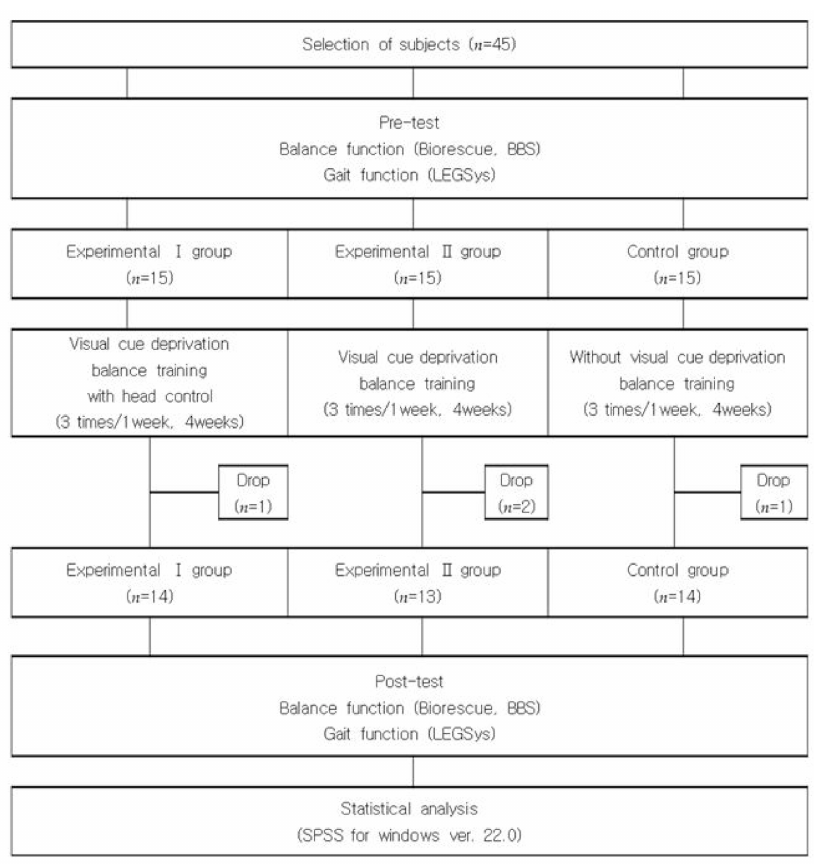
Figure 1. Diagram of experimental